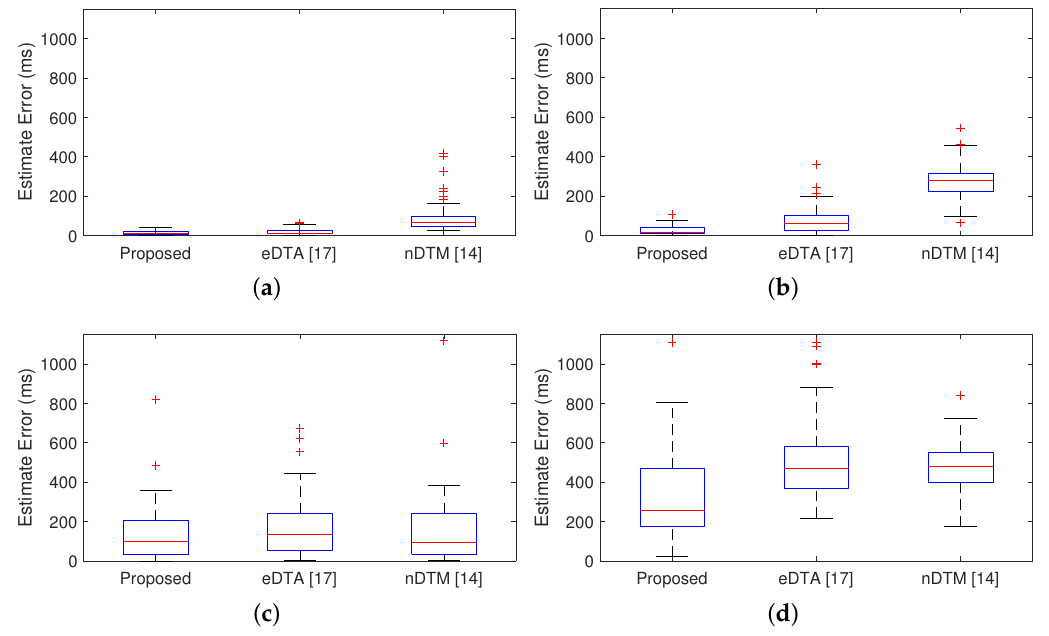
Figure 9. The performance comparison of the proposed algorithm and two conventional methods. ( a ) Results of onset detection for the best case (subject #1). ( b ) Results of offset detection for the best case (subject #1). ( c ) Results of onset detection for the worst case (subject #10). ( d ) Results of offset detection for the worst case (subject #10).